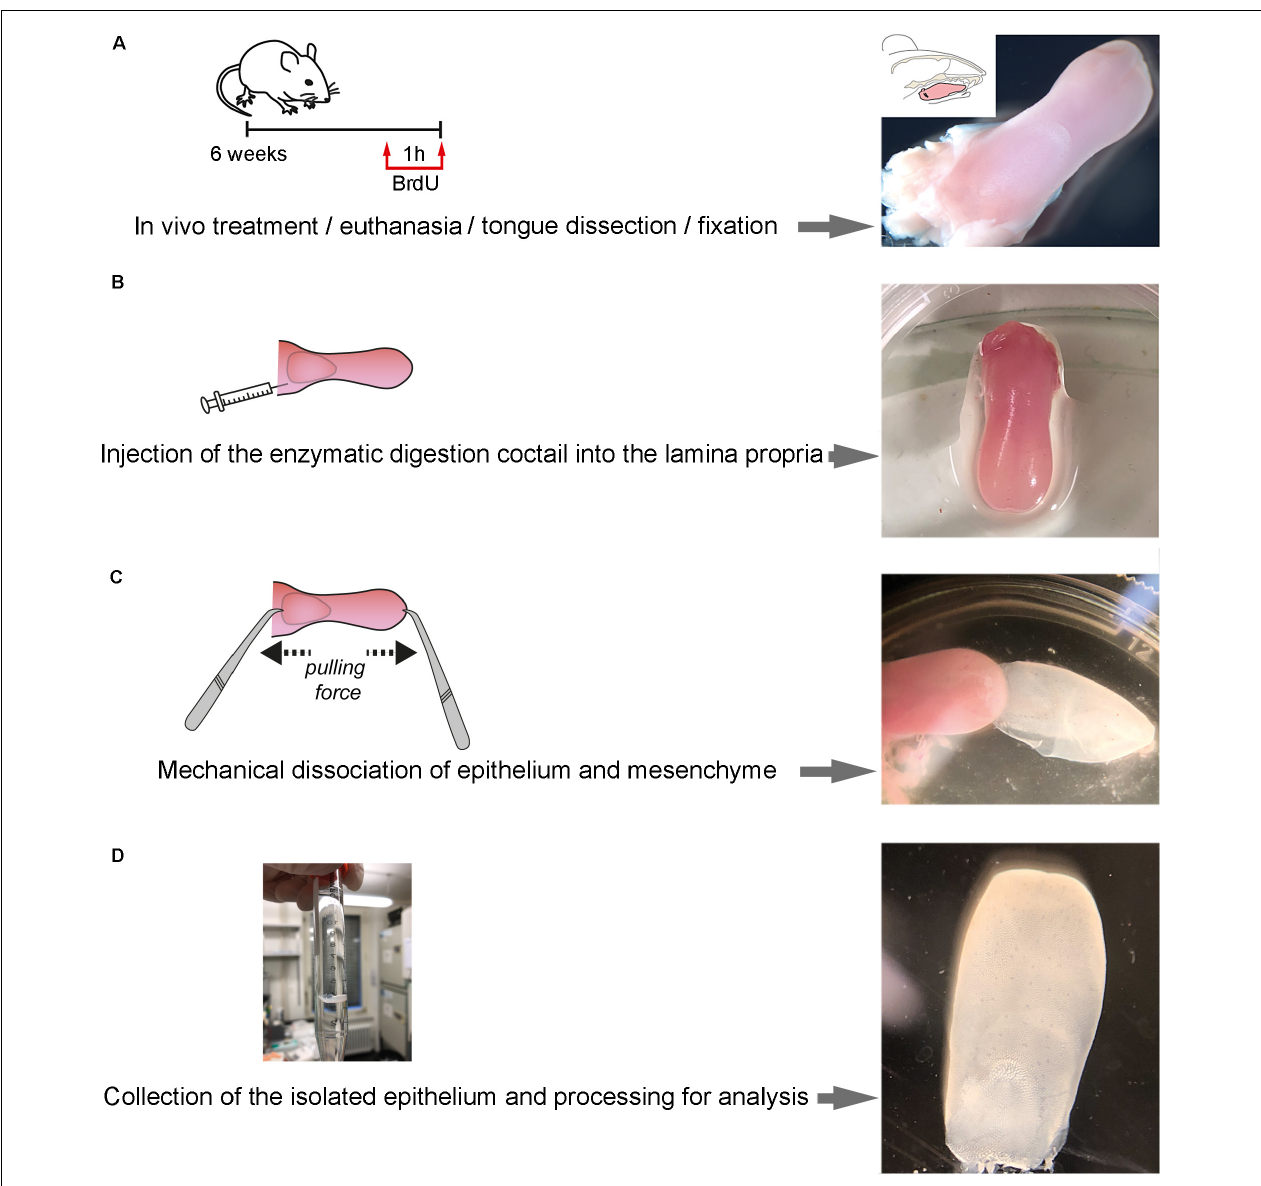
FIGURE 1 | Step-wise procedure of enzymatic separation of tongue epithelium. (A) Schematic representation of the in vivo treatment and representative picture of the isolated tongue. A 6-week old mouse was injected with BrdU at 50 mg/kg. Upon 1 h of BrdU incorporation, the mouse was euthanatized and immediately after the tongue was dissected. (B) Schematic representation of the injection of the enzymatic cocktail at the lamina propria area of the tongue and representative picture of the treated isolated tongue. (C) Schematic representation of the procedure of mechanical separation of the tongue epithelium and representative picture. (D) Representative pictures of the separated epithelium at the end of the procedure.